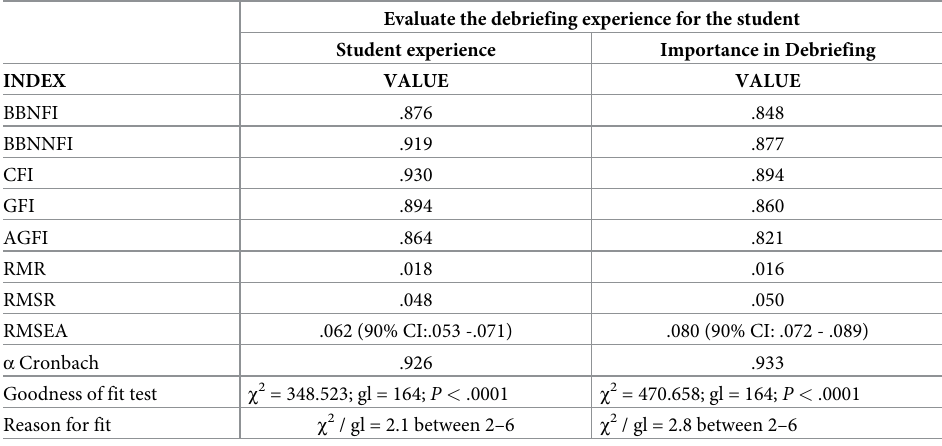
Table 4. Indices of goodness of fit of the confirmatory model the Spanish version Debriefing Experience